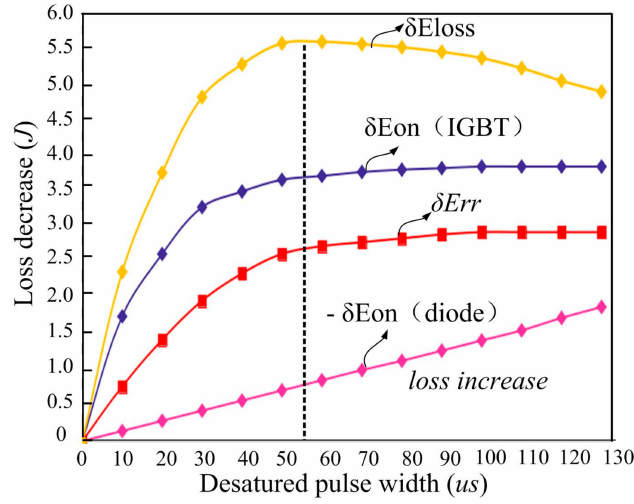
Figure 8. Diagram of the relation between optimal loss and the desaturation time at 3500 V/1000